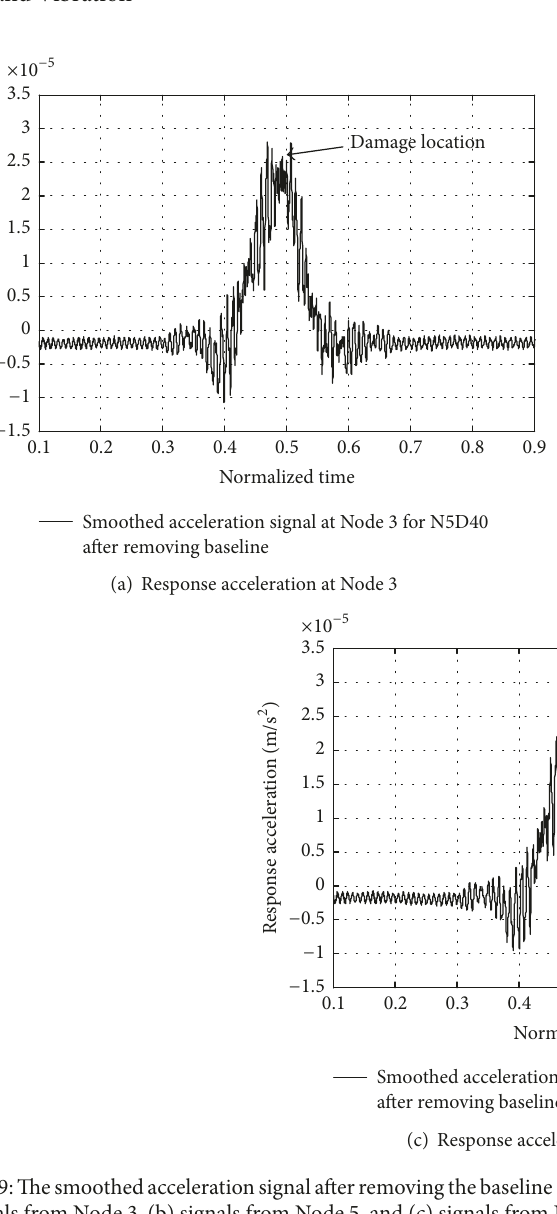
signal after removing the predicted baseline. For example, if the velocity, the length, 𝑛 𝑡 , and 𝑛 are 0.3 m/s, 6 m, 9, and 4, respectively, then 𝑡 1 = 7 s and 𝑡 2 = 9 s. On the other hand, (4) gives sum of the squares of the acceleration data when the moving load is around the